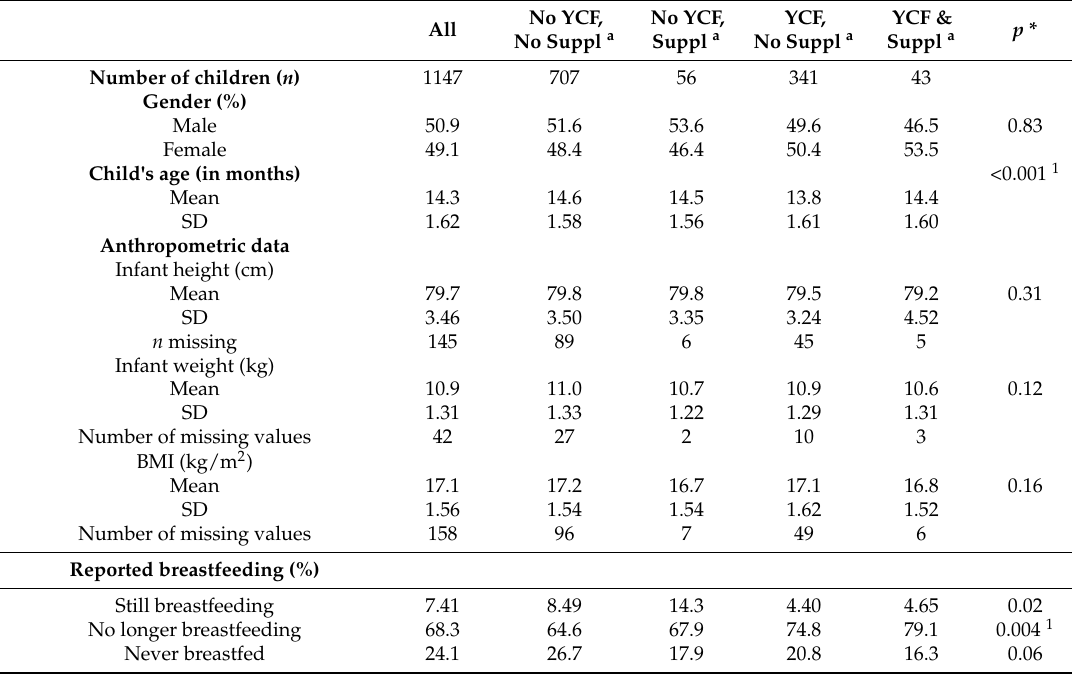
Table 1. Gender, age, height, weight, BMI and diet characteristics (reported breastfeeding, energy intake and nutritional quality indicators) in the four groups of children